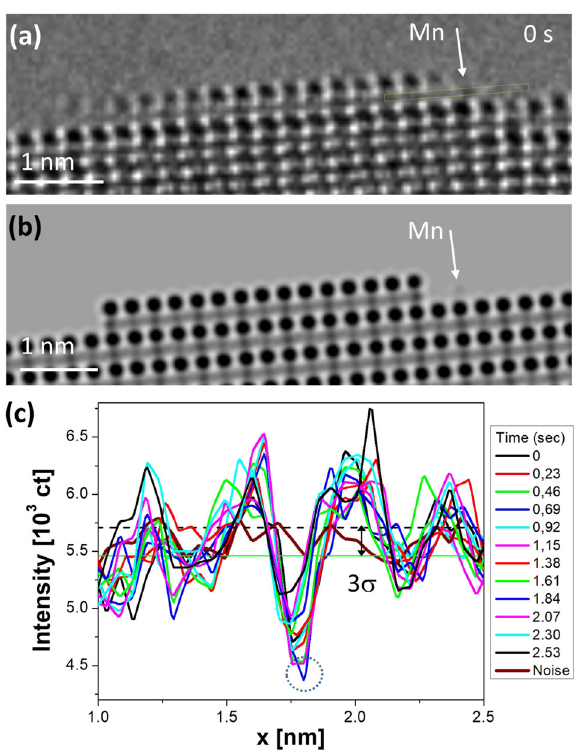
Fig. 4 Slowed down Mn surface mobility due to a unit cell height surface step at a LSMO (001) facet in 0.5 Pa of H 2 O. a First HRTEM image of a time sequence taken at a frame rate of 4.4 fps with the surface step taken at the same conditions as in Fig. 3; see Movie M02. b Simulated HRTEM image with the step and 3 Mn occupation contrast on a slightly displaced B- site column. c Line pro fi les of the time sequence taken at the B-layer as indicated by the green box in a . It is showing an increased sticking time of a triple Mn column of 1.4 s near the step edge compared to ≤ 0.23 s at the fl at surface, providing evidence for a locally increased surface